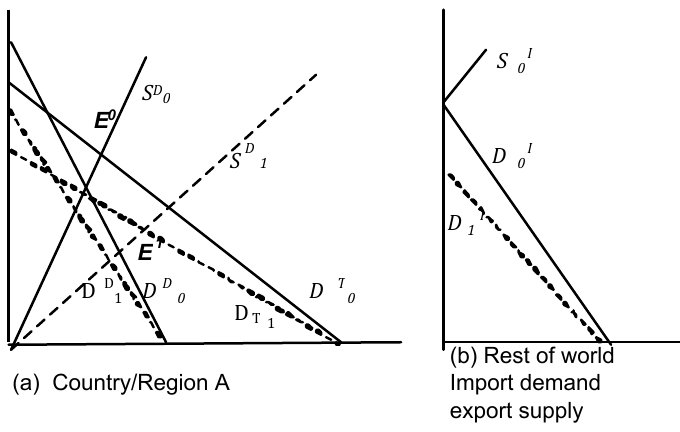
Figure 2. Trade of credence